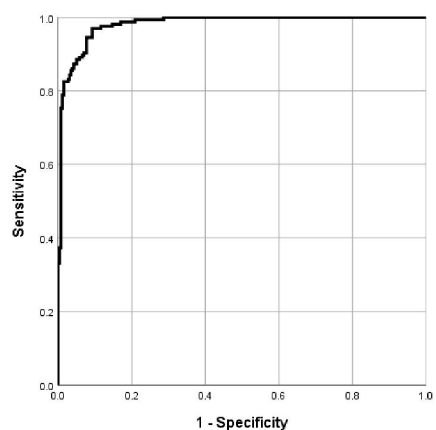
Figure 3. Receiver operating characteristics curve demonstrating an excellent goodness of fit for mRNA expression signature with an area under the curve of 0.981 for the di ff erentiation between WHO grade II and WHO grade IV